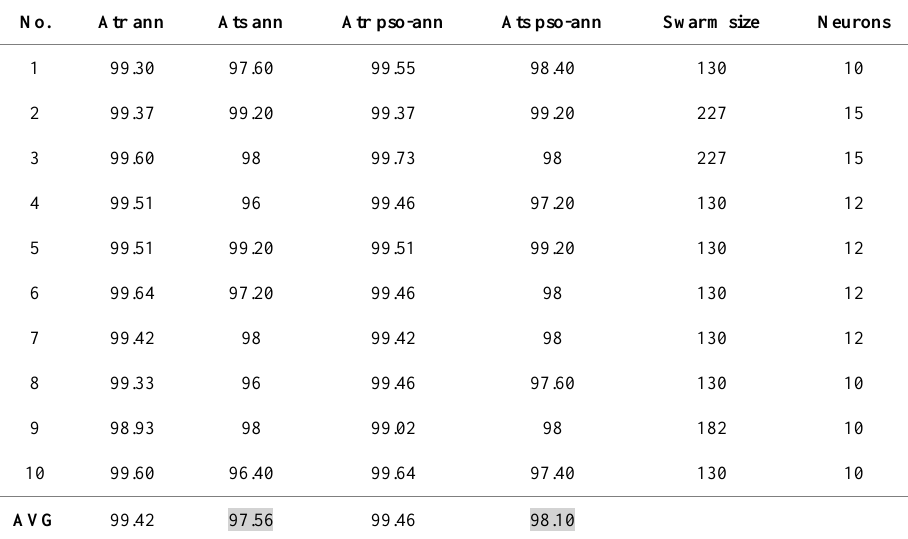
Table 3. Comparing other approaches and the proposed method.